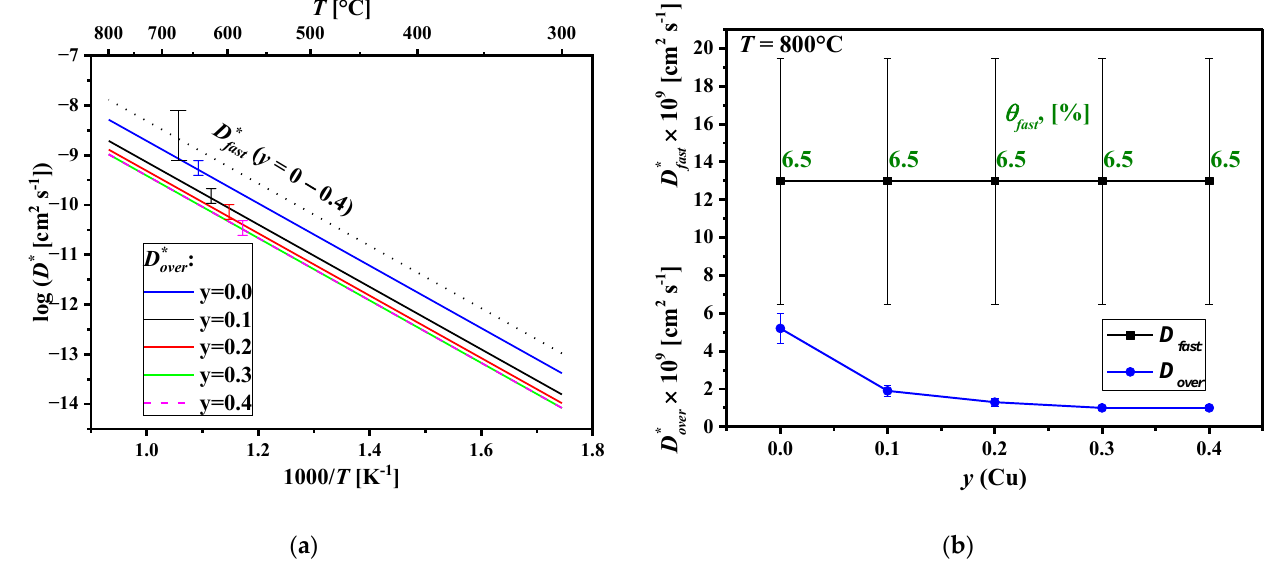
Figure 8. Arrhenius plots ( a ) and concentration dependencies ( b ) of the oxygen tracer diffusion coefficients for Nd 1.6 Ca 0.4 Ni 1 − y Cu y O 4+ δ samples according to TPIE with C 18 O 2 data. 3.5. Electrochemical Performance of the Electrodes with Nd 1.6 Ca 0.4 Ni 1 − y Cu y O 4+ δ Functional Layers. Factors Influencing the Electrode Performance Impedance data for the Nd 1.6 Ca 0.4 Ni 1−y Cu y O 4+δ /SDC symmetrical cells with functional